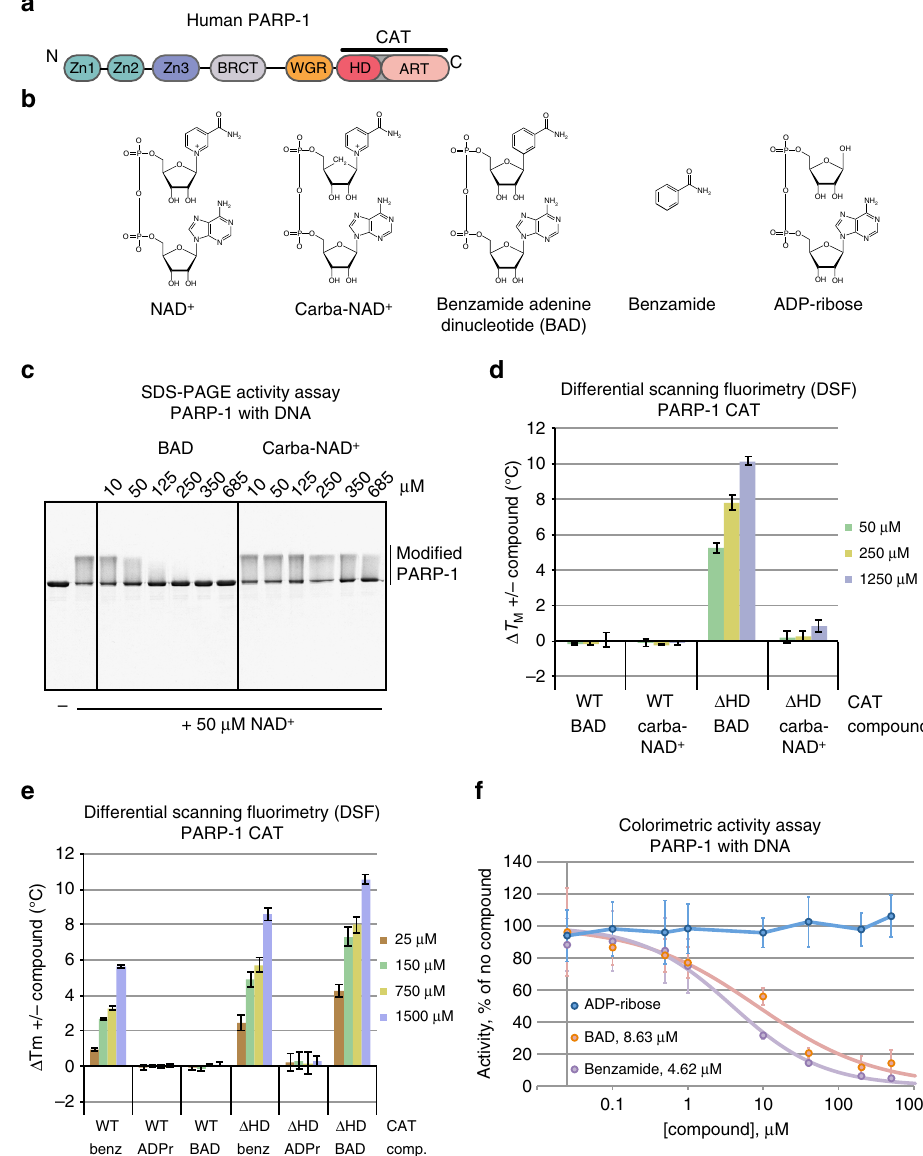
Fig. 1 Non-hydrolyzable NAD + analog binding and inhibition of PARP-1. a Schematic representation of PARP-1 domains. b Chemical structure of key compounds used in this study: NAD + , non-hydrolyzable NAD + analogs carba-NAD + and benzamide adenine dinucleotide (BAD), benzamide, and ADP- ribose (ADPr). c SDS-PAGE PARP-1 activity assay (1 μ M DNA, 1 μ M protein, 50 μ M NAD + ) in the presence of carba-NAD + and BAD. An image of the entire gel is included in Supplementary Fig. 10. d, e Differential scanning fl uorimetry (DSF) experiment using PARP-1 CAT domain WT or Δ HD (5 μ M) and various amounts of carba-NAD + , BAD, benzamide, and ADP-ribose. Δ T M is calculated by subtracting the T M and Δ T M obtained in the absence of compound from the T M obtained in the presence of compound. The experiments were all performed in triplicate for which averages and standard deviations are shown. f Colorimetric assay of full-length PARP-1 DNA-dependent activity in the presence of ADP-ribose, benzamide, and BAD using 20 nM PARP-1, 40 nM DNA (18-bp duplex) and 50 μ M NAD + (99:1, NAD + :bio-NAD + ). Experiments were performed in quadruplicate and the averages and standard deviations for each compound concentration are shown, as well as the average IC50 values for benzamide and BAD